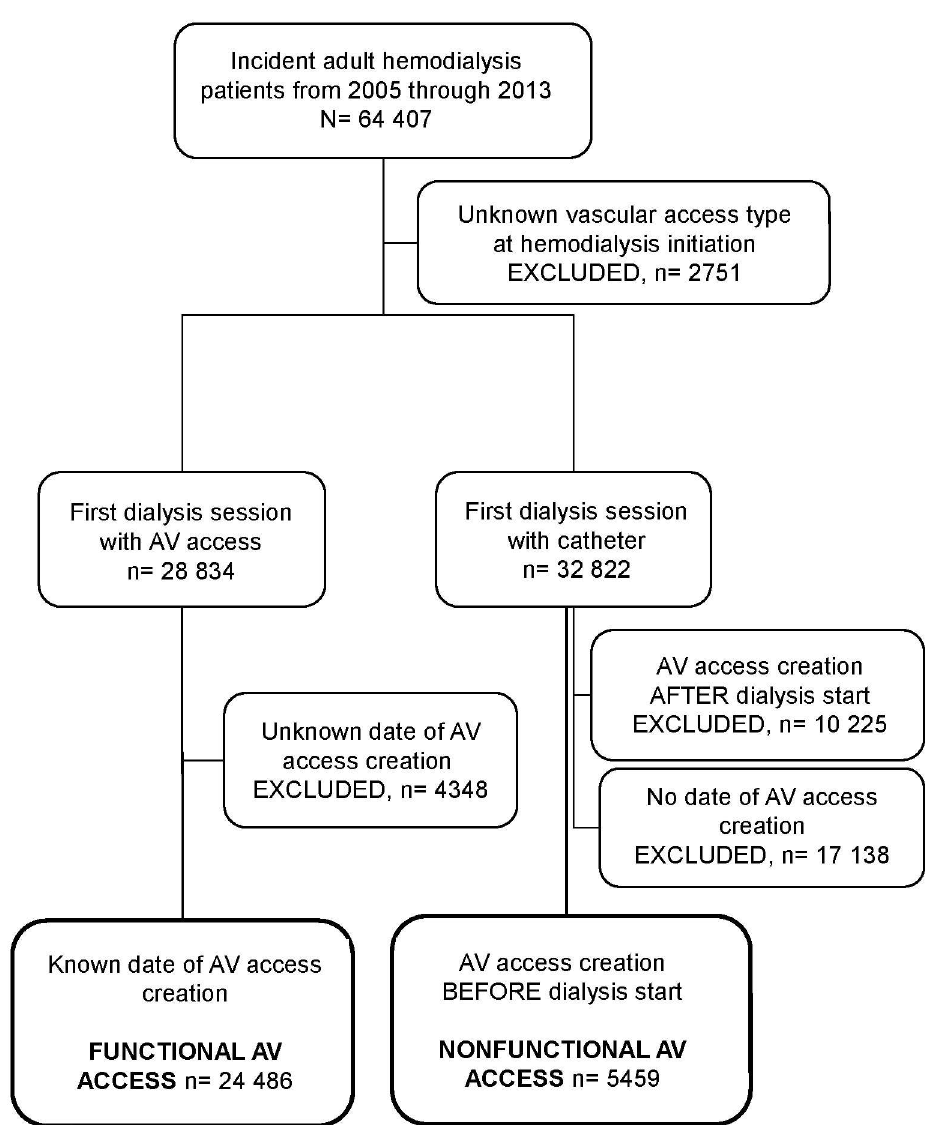
Fig 1. Cohort selection. Abbreviations: AV,